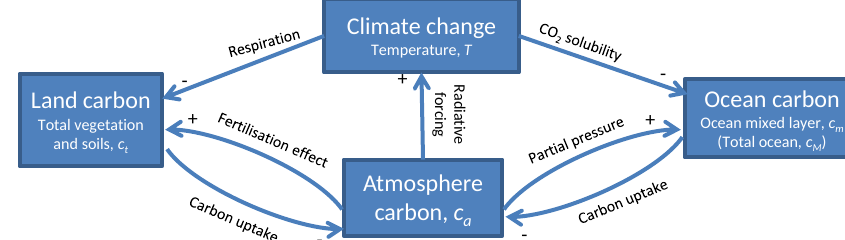
Figure 1. Climate–carbon cycle feedbacks and state variables as represented in the stylised model introduced in this paper. Carbon stored on land in vegetation and soils is aggregated into a single stock c t . Ocean mixed layer carbon, c m , is the only explicitly modelled ocean stock of carbon; though to estimate carbon cycle feedbacks we also calculate total ocean carbon (Eq.